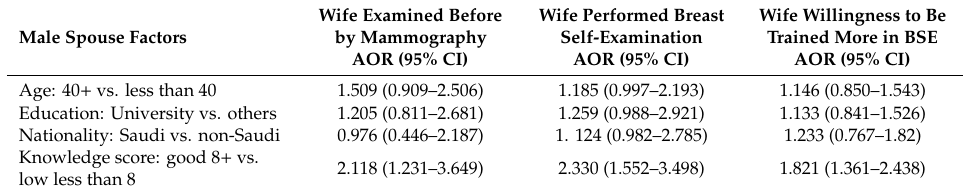
Table 4. Adjusted odds ratio (AOR) and 95% confidence intervals (95% CI) of male spouse factors associated with wife practices and attitudes related to breast